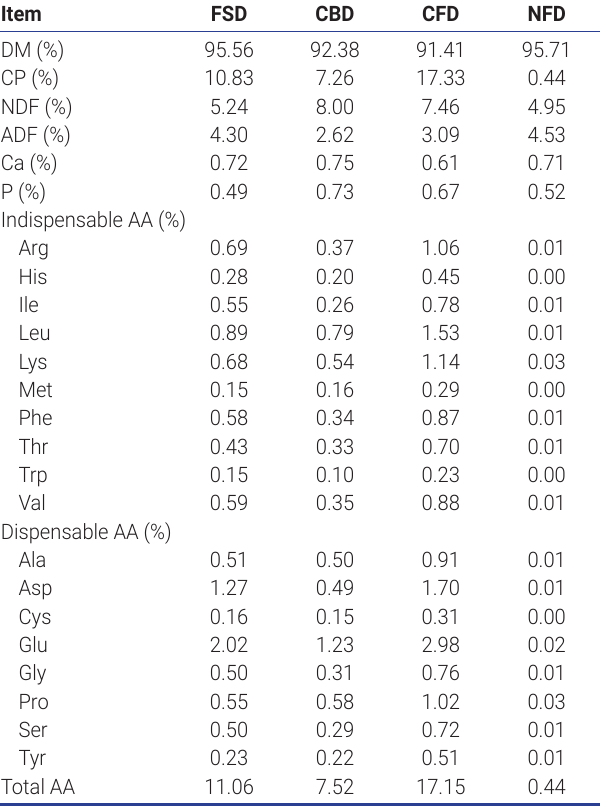
Table 2. Analyzed composition of experimental diets 1) (as-fed basis)